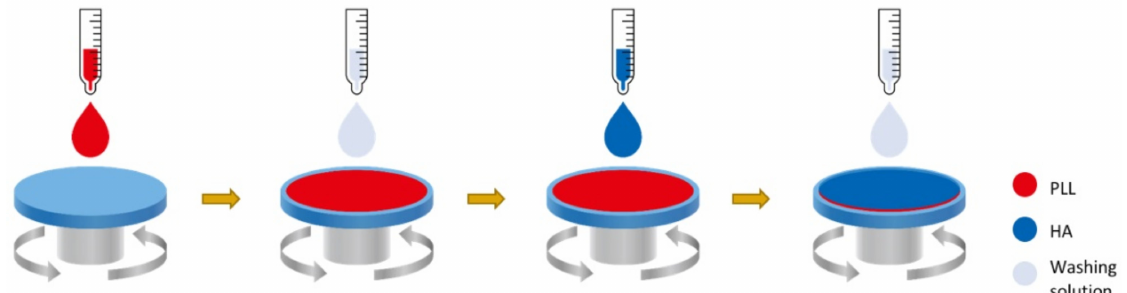
Figure 14. Preparation method of a dual polymer layer on the silicone implant with Hyaluronic acid (HA) and poly-L-lysine (PLL). The first and second coating layers consist of PLL and HA, respectively. Both the coating layers were uniformly distributed on the silicone implant and exhibited synergetic effects on capsular fibrosis formation